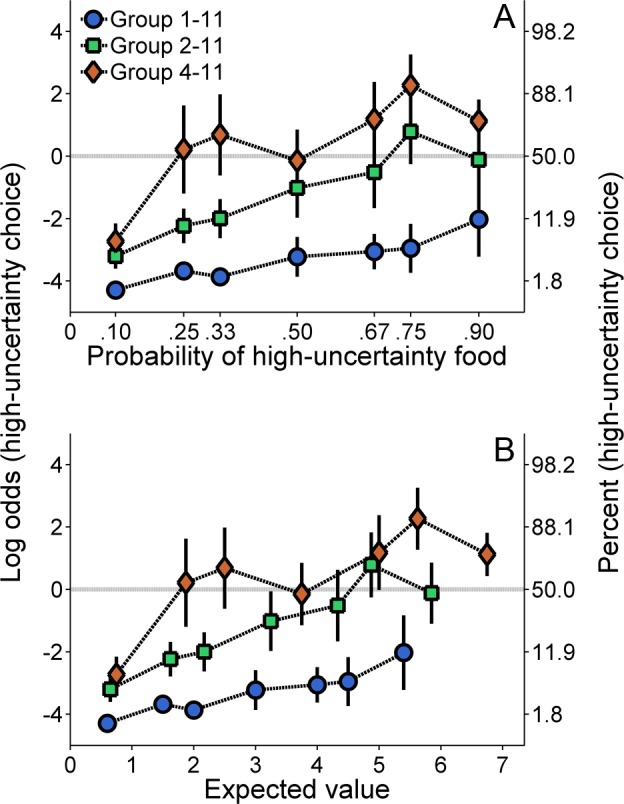
Mean (±SEM) log odds of high-uncertainty choices for each group in Experiment 1 as a function of the probability of high-uncertainty food delivery (A) and the expected value of the high-uncertainty outcome (B).The horizontal line indicates neutral preference of the two outcomes. Values below this line reflect risk aversion (more low-uncertainty than high-uncertainty choices), and values above it reflect risk proneness (more high-uncertainty than low-uncertainty choices). A second ordinate showing the percentages corresponding to the log odds values was included to aid interpretation.